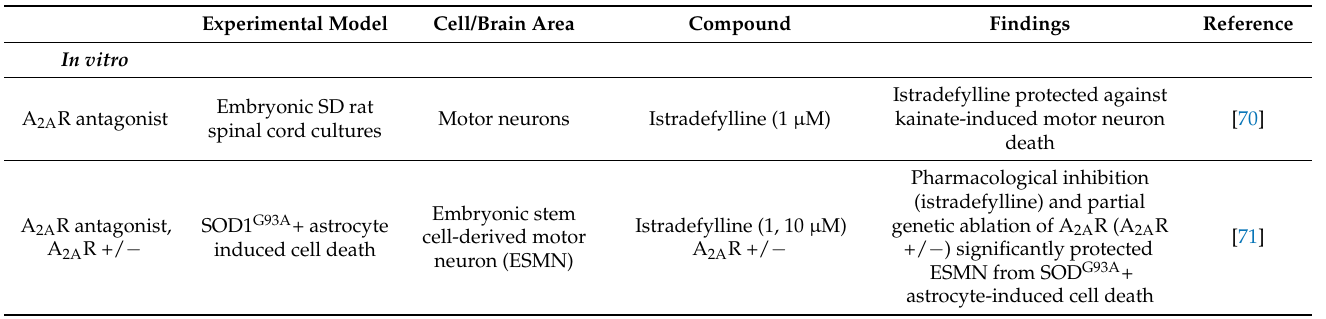
Table 3. Pharmacological studies of adenosine A 2A receptor agonists and antagonists in ALS models (in vitro, in